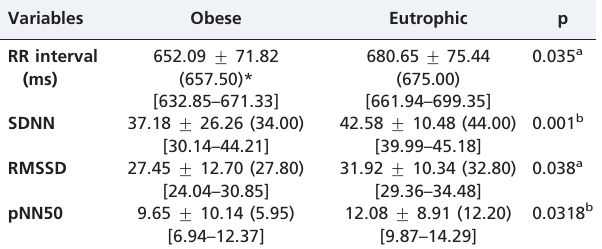
Table 3 - Linear index values of heart rate variability (time domain) of obese and eutrophic children.